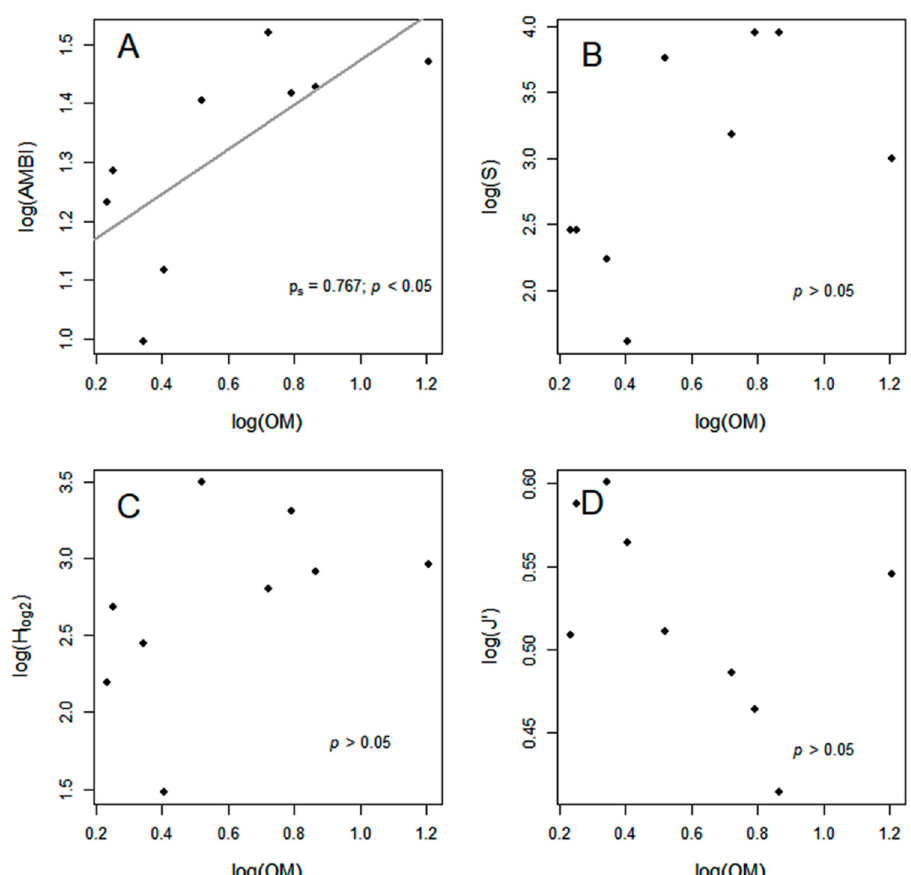
Figure 4. Relationship between concentration of organic matter (OM) and values of AMBI ( A ), richness ( B ), Shannon diversity index ( C ), and Pielou equitability index ( D ).